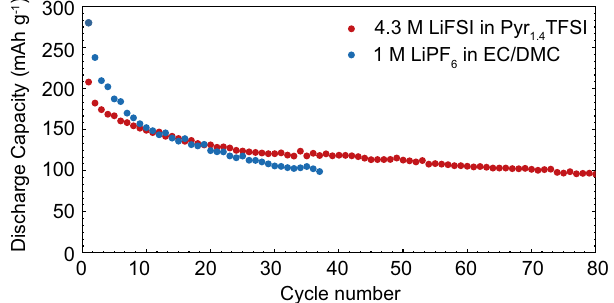
Fig. 5 Cycling stability measurements. Cycling stability of BiF 3 cathode measured in 1 M LiPF 6 -EC/DMC and 4.3M LiFSI-Pyr1,4TFSI electrolytes at a current density of 30mAg ‒ 1 within the voltage range of (2 ‒ 4 V vs . Li + /Li). Drop of charge-storage capacity below 100 mAh g − 1 was considered as a cutoff